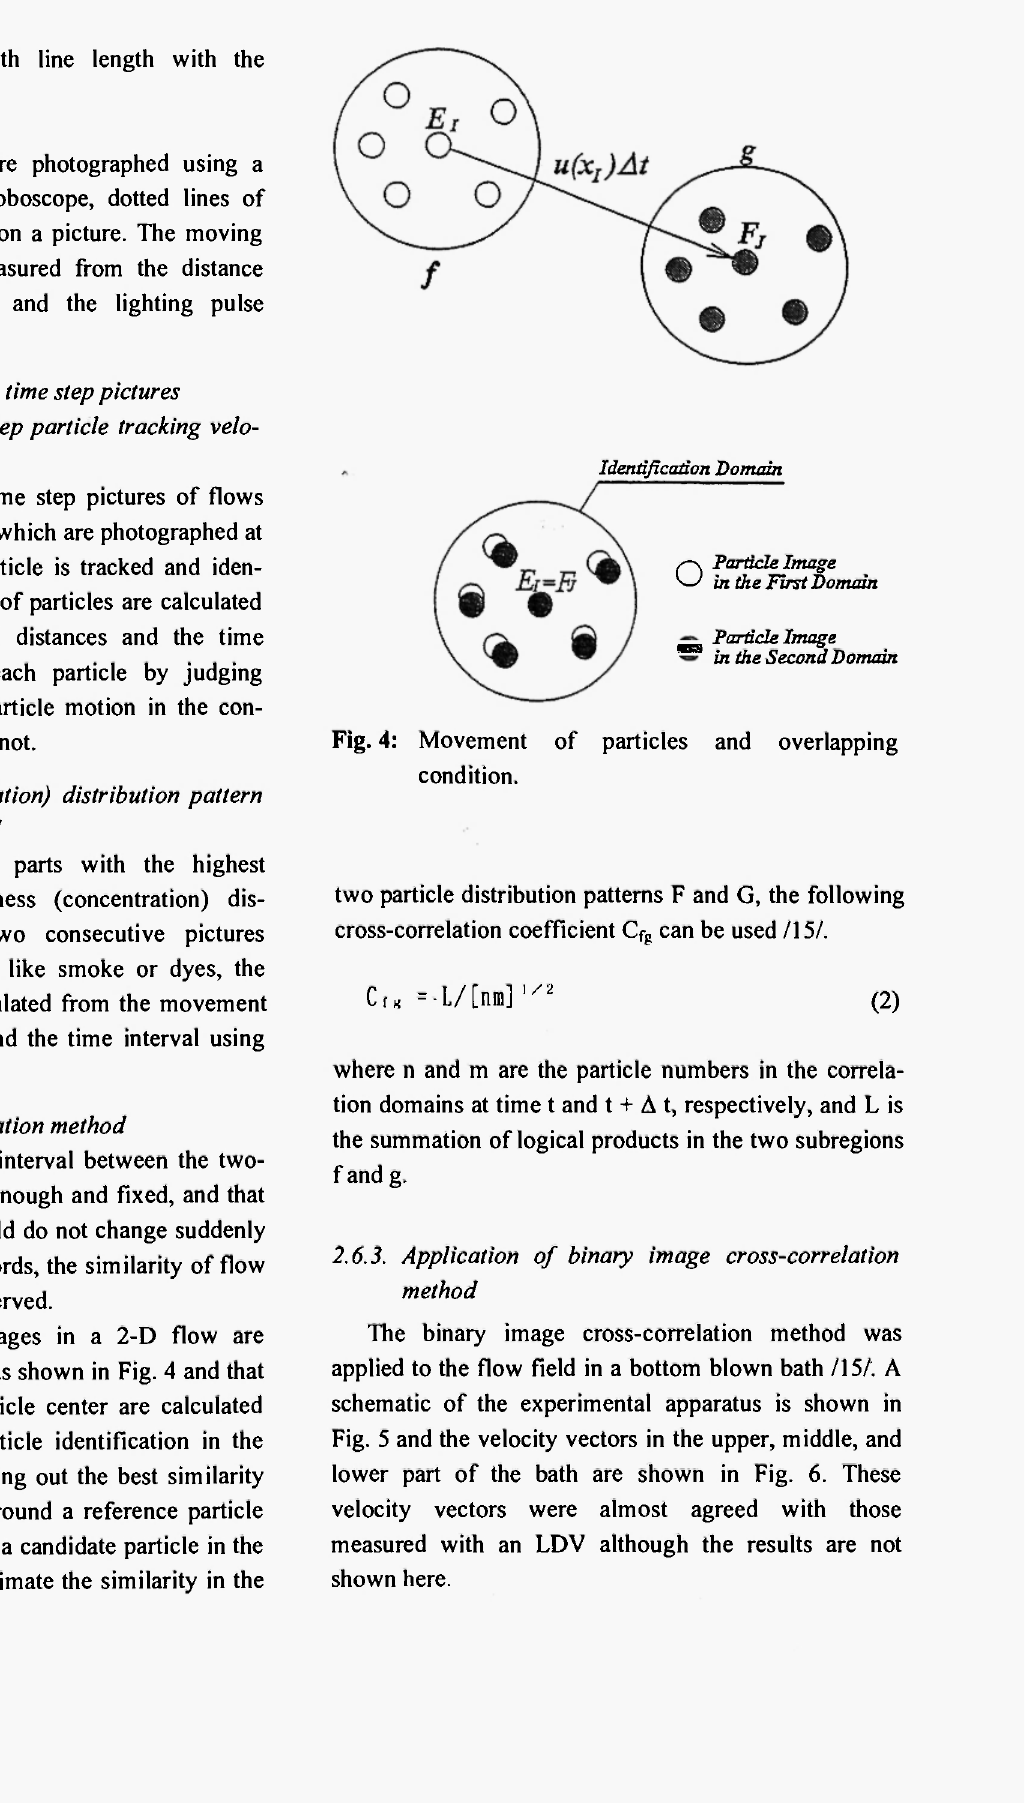
Identification Domain